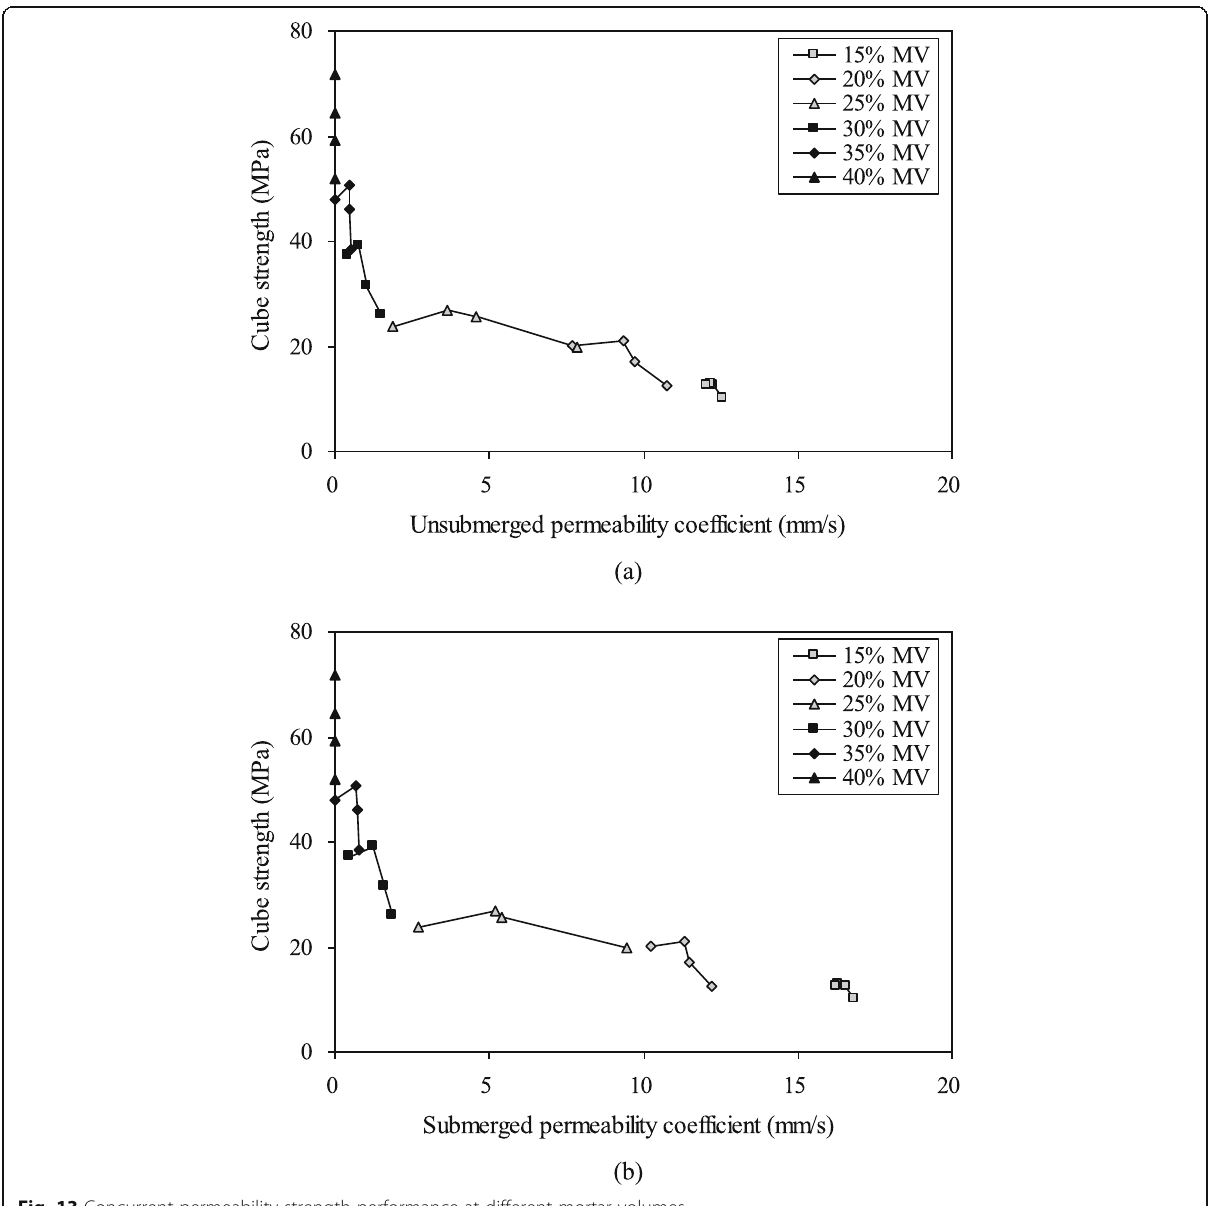
Fig. 13 Concurrent permeability-strength performance at different mortar